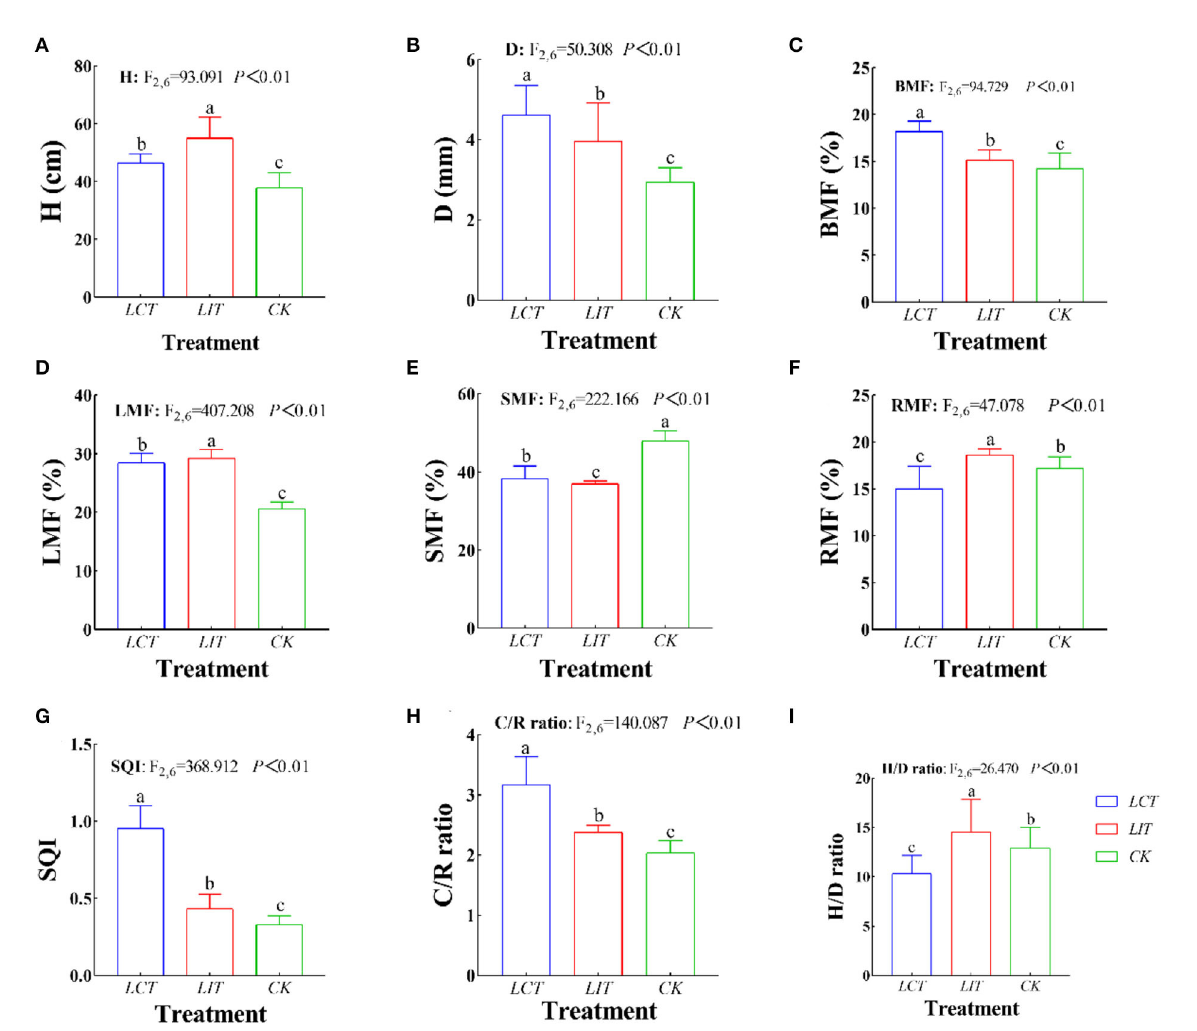
FIGURE5 The growth and biomass allocation of Pinus massoniana Lamb . The logging methods are LCT , logging of the competitive trees; LIT , logging of the inferior trees; CK , unlogged control. The growth indexes are H, plant height (cm); D, ground-diameter (mm); BMF, branch mass fraction (%); LMF, foliage mass fraction (%); SMF, stem mass fraction (%); RMF, root mass fraction (%); C/R ratio, crown-root ratio; H/D ratio, height-diameter ratio; SQI, seedling quality index. Data shown are the mean ± standard deviation ( n = 3). Different lowercase letters indicate